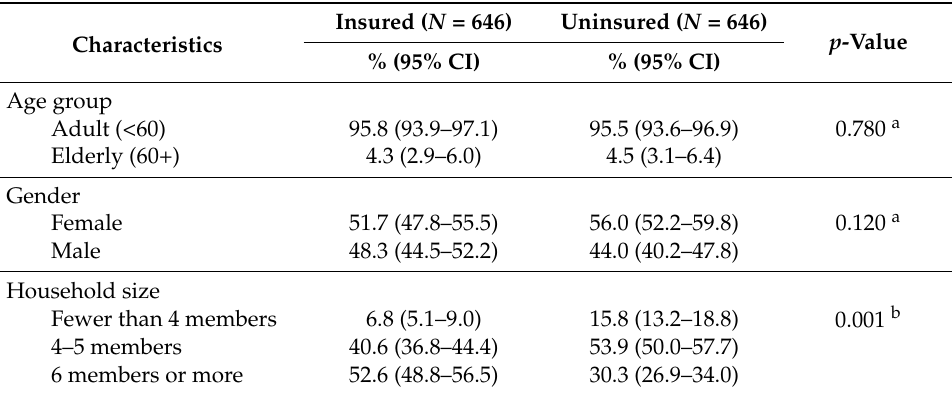
Table 2. Background characteristics.